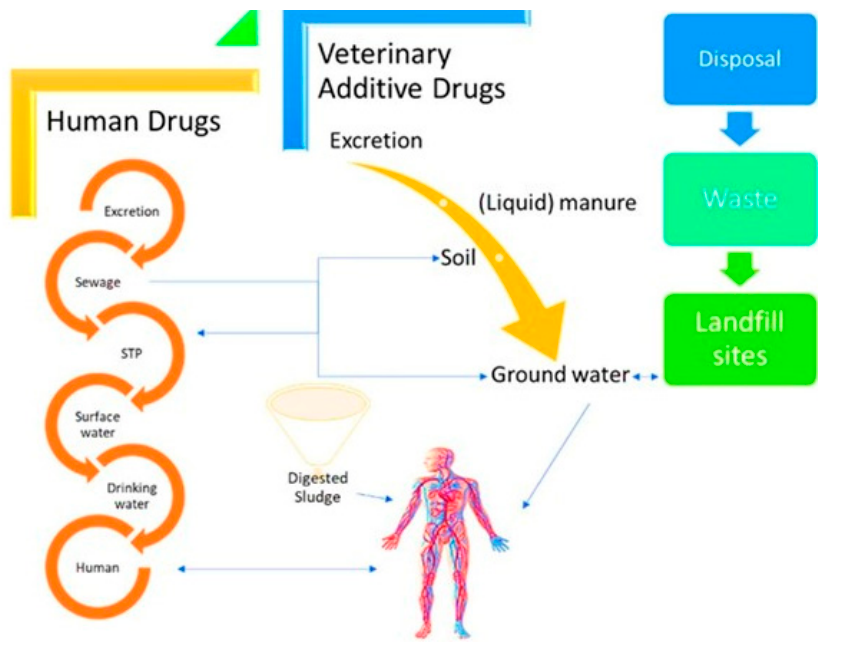
Figure 1. The different sources of contaminants in the wastewater system. Reprinted/adapted with permission from Ref. [24].